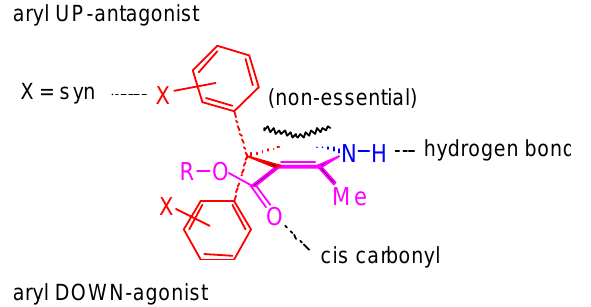
Figure 2. Proposed receptor-bound geometry of DHP/ DHPM calcium channel modulators [9].